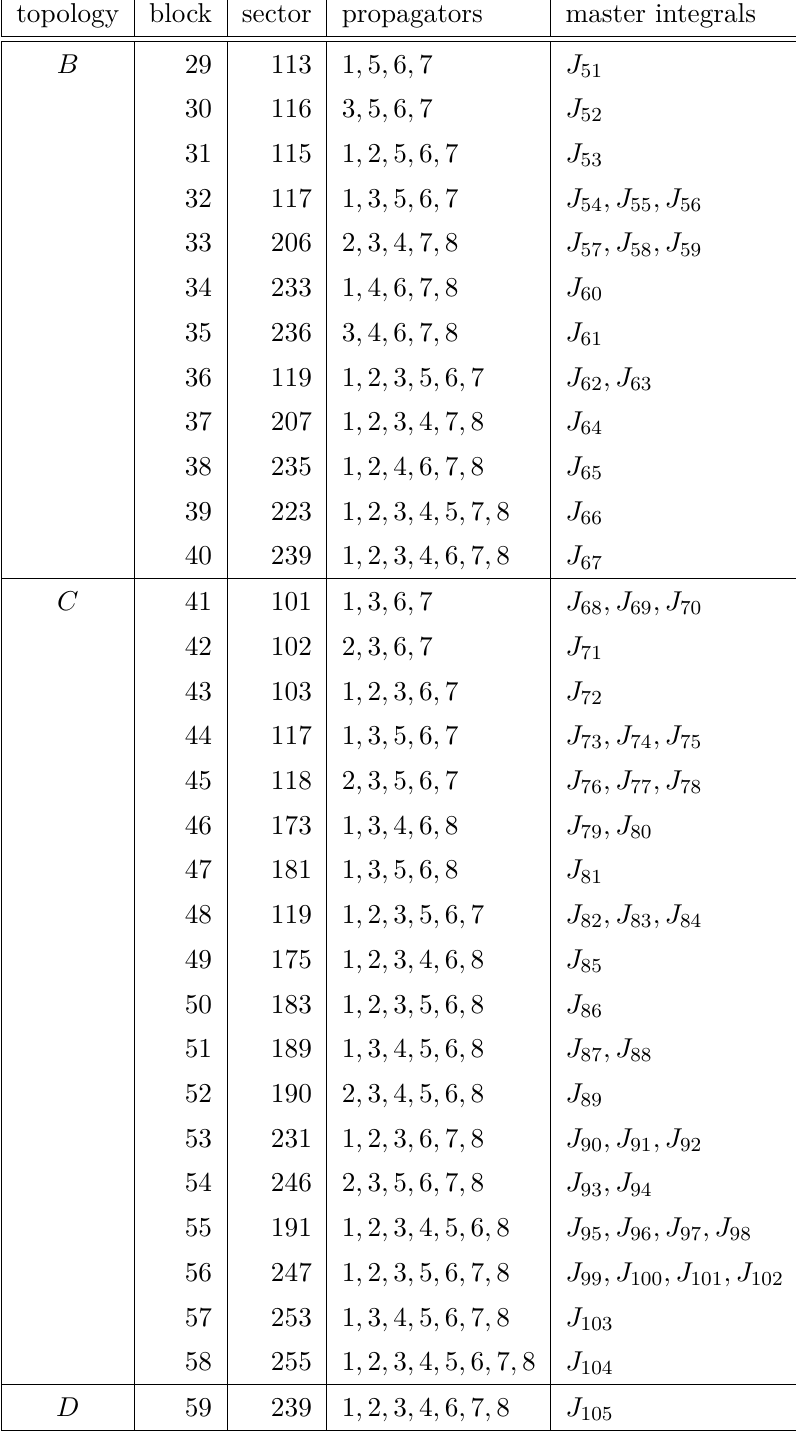
Table 4 . Overview of the set of master integrals